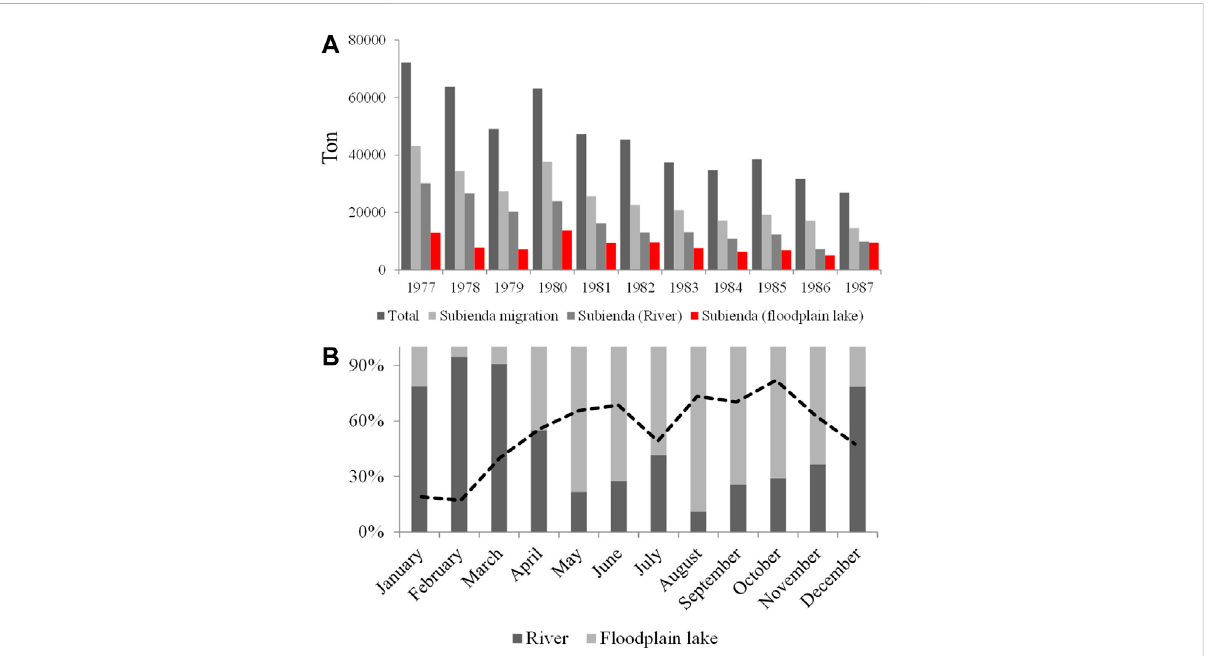
FIGURE 9 Fisheries landings of the Magdalena River. (A) Yearly report from the river channel and fl oodplain lakes from 1977 to 1987 years; (B) Monthly proportioninthecatchesobtainedbyaquaticsystems(river,lake)intheyear1995;dottedline:riverdischargetrend.DataobtainedfromINPA(1998), INPA